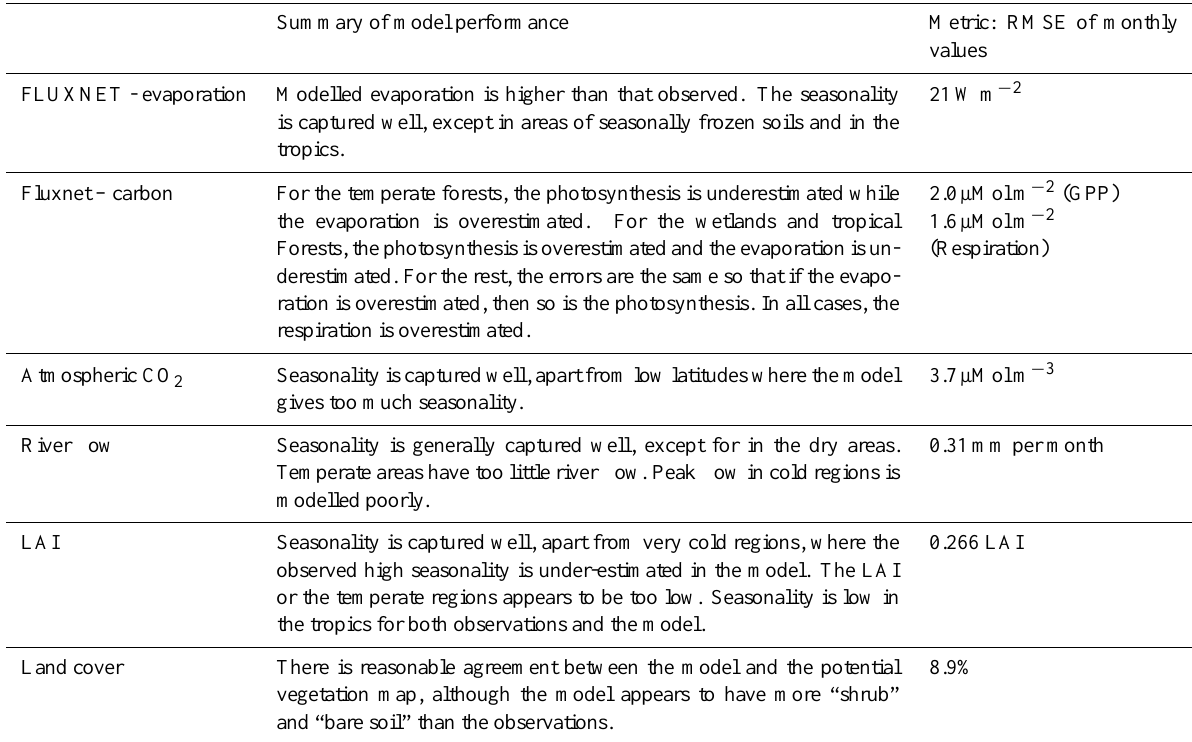
Table 2. Summary metrics of performance of JULES against datasets. Summary of model performance